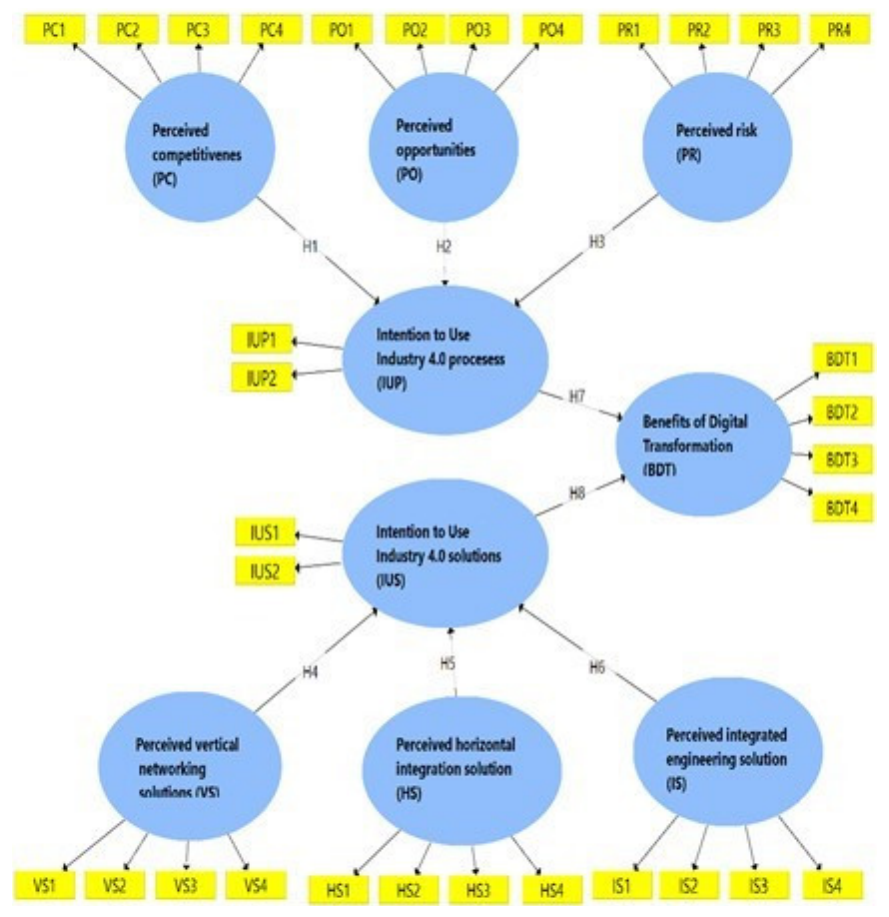
Figure 1. Description of the proposed structural model.